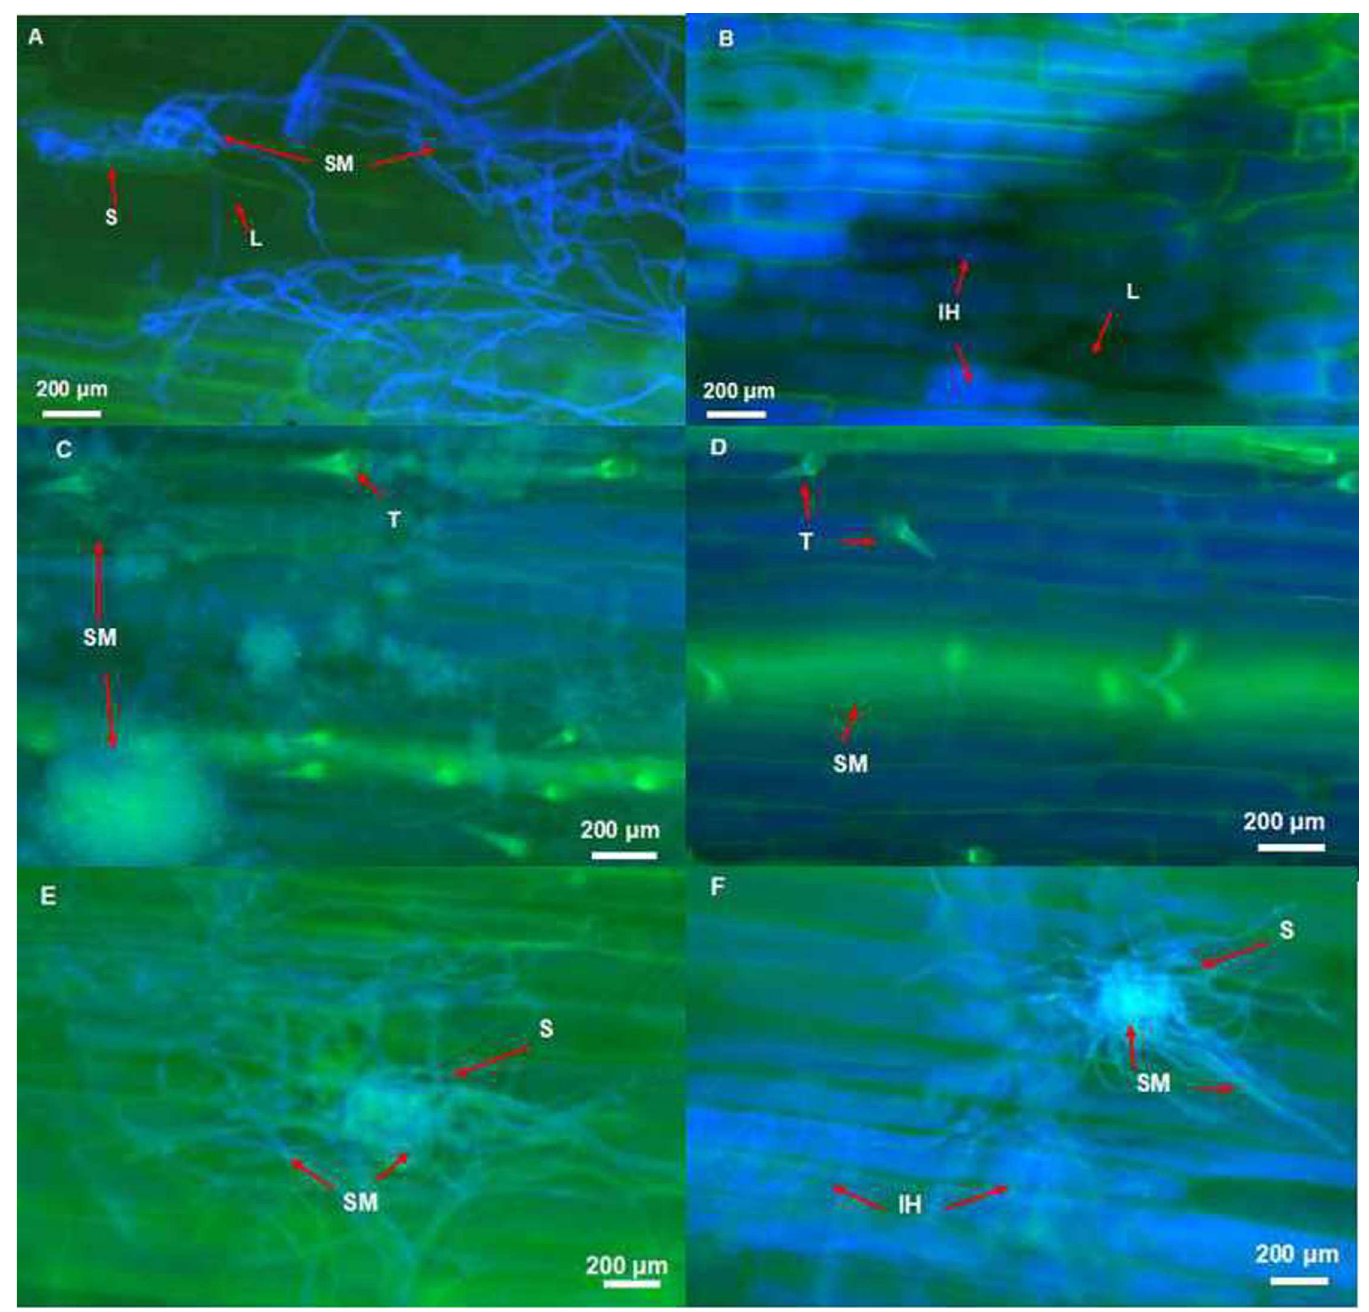
Fig 4. Fusarium pseudograminearum colonization of barley leaf sheath tissues. A: A mass of surface myceliumenteringthe open stoma at the base of heavilyinfected second leaf sheath at 28 dpi in the drought-stressed genotypeFranklin. B: Intracellularhyphaegrowingwithin epidermalcells at the base of heavilyinfected second leaf sheath tissues at 28 dpi in the well-watered genotypeFranklin. C: Large quantity of surface myceliumoccurred aroundtrichomes at 28 dpi in the first leaf sheath of the drought-stressed seedlingof Fleet. D: A small amount of myceliumappearedaroundtrichomes at 28 dpi in the first leaf sheath of the well-watered genotypeFleet. E: Large quantity of hyphaere-emerging from stoma at 28 dpi in the first leaf sheath of the drought-stressed genotypeFleet. F: Small quantity of hyphae re-emerging from stomata and a large quantity of intracellularhyphaegrowingwithin and across epidermalcells at 28 dpi in the first leaf sheath of the well-watered genotypeFleet. (Tissues were stained using Fluorescent brightener28 and viewedunder ultravioletlight.) S: stomata; L: lesion; IH: intracellularhyphae;SM: surface mycelium; T:trichome.